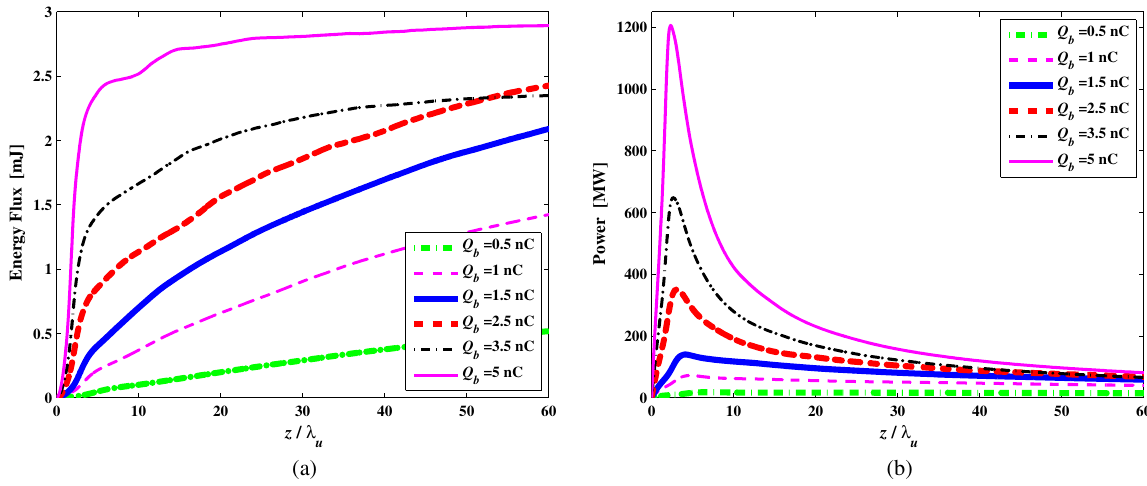
FIG. 6. Energy flux (a) and average power (b) along the beam